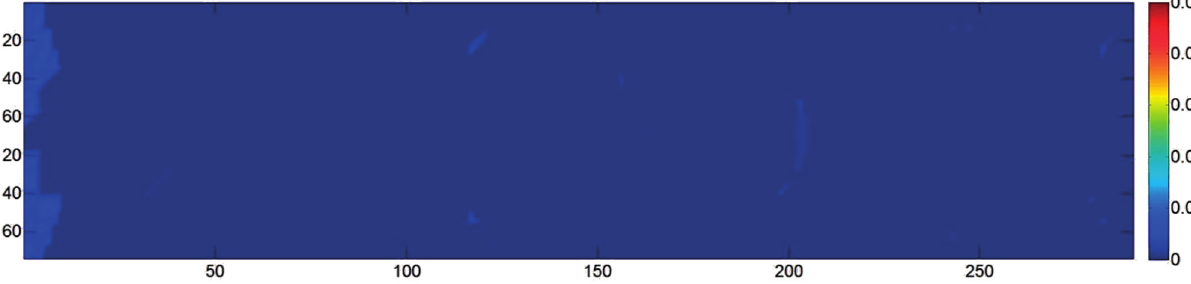
Figure 10. Case 3-D: standard deviation of the error with 80% overlap with four